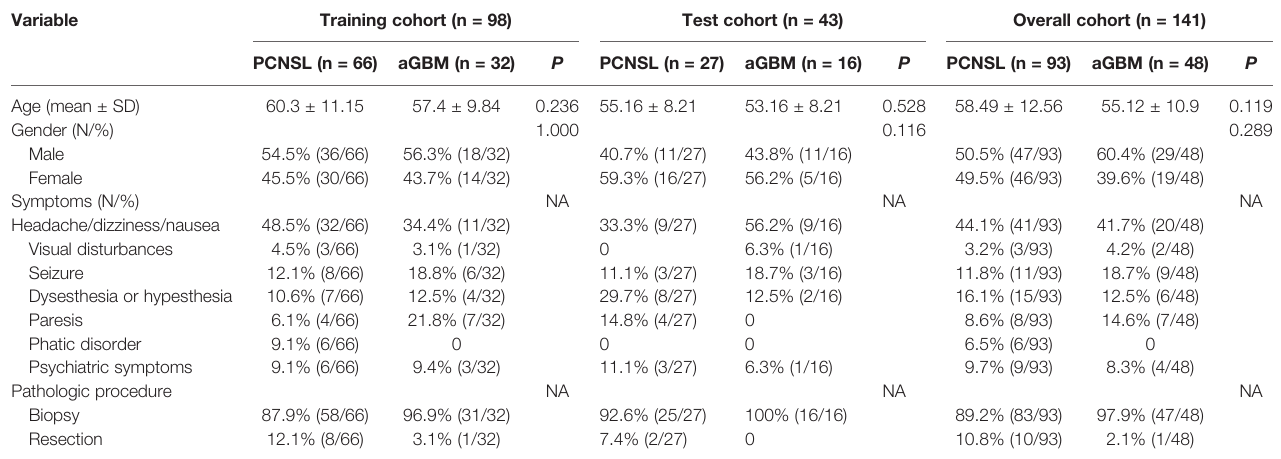
TABLE 2 | Baseline demographics of patients.